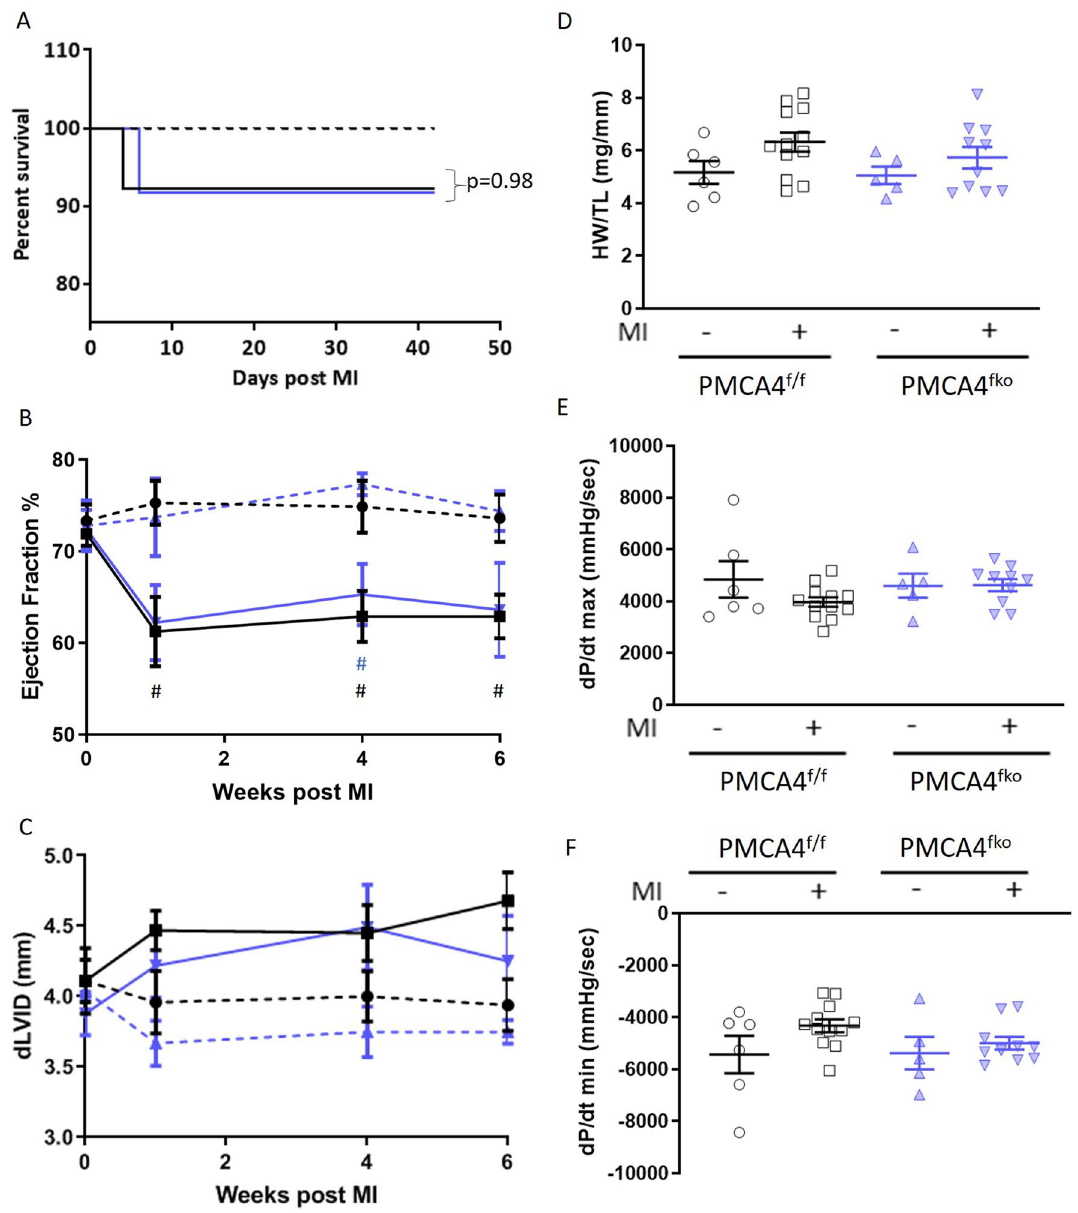
Figure 7. PMCA 4 deletion from fibroblasts does not affect cardiac structure or function post-MI. ( A ) Kaplan– Meier survival plots for PMCA4 flox/flox (black) and PMCA4 fko mice (blue) followed for 6 weeks post MI (solid lines) or sham (dashed lines) surgery. Starting populations: control sham n = 6, control MI n = 13, PMCA4 fko sham n = 6, PMCA4 fko MI n = 12. ( B ) Ejection fraction and ( C ) Diastolic left ventricular diameter tracked for 6 weeks post-MI or sham surgery by echocardiography. # p < 0.05 versus sham control at matched time point ( D ) Heart weight/tibia length ratio 6 weeks post-MI or sham surgery. ( E ) dP/dt max and ( F ) dP/dt min 6 weeks post MI or sham surgery. control sham n = 6, control MI n = 12, PMCA4 fko sham n = 6, PMCA4 fko MI n =